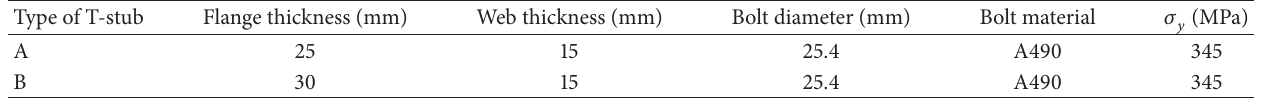
Table 3: Size and geometry of T-stubs.